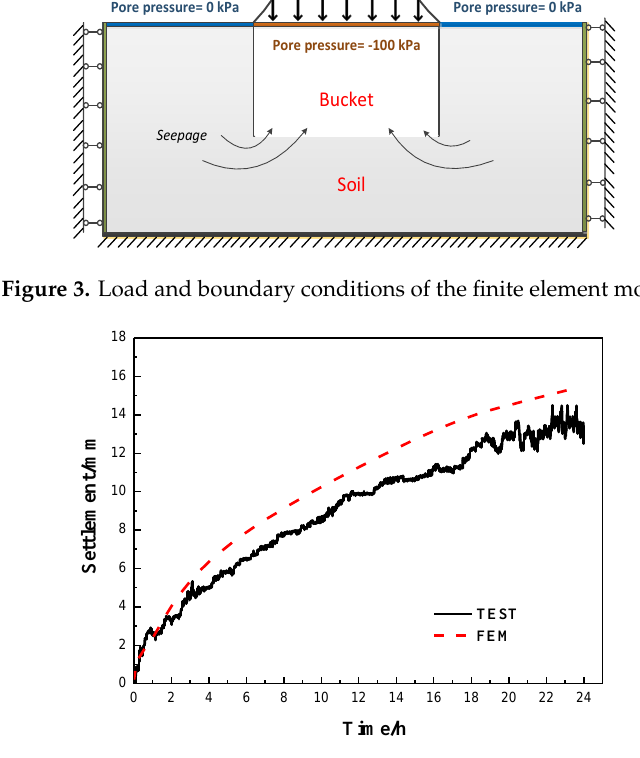
Figure 4. Comparison of finite element method (FEM) model and model tests results (model scale 1:100; water head is 6 m).